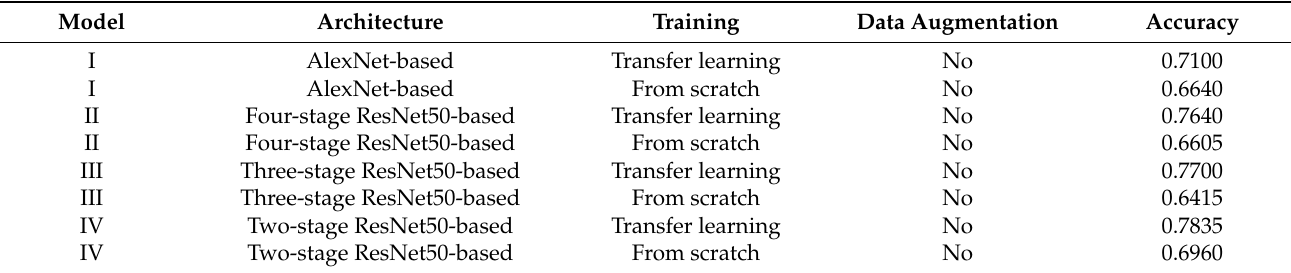
Table 1. Average cross-validation results of different